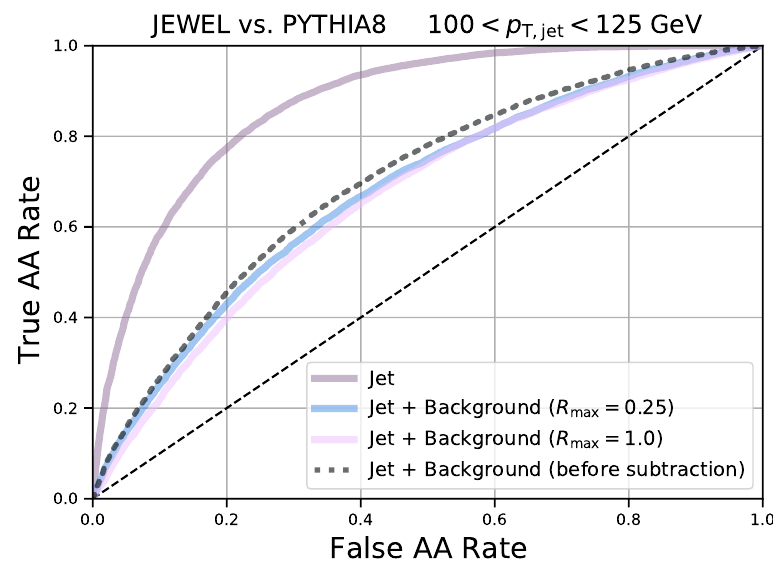
Figure 11 . ROC curves comparing the performance with (i) Hard jet particles only, (ii) Hard jet particles and background particles, with constituent subtraction applied (for two different values of R max , and (iii) Hard jet particles and background particles, without any background subtraction